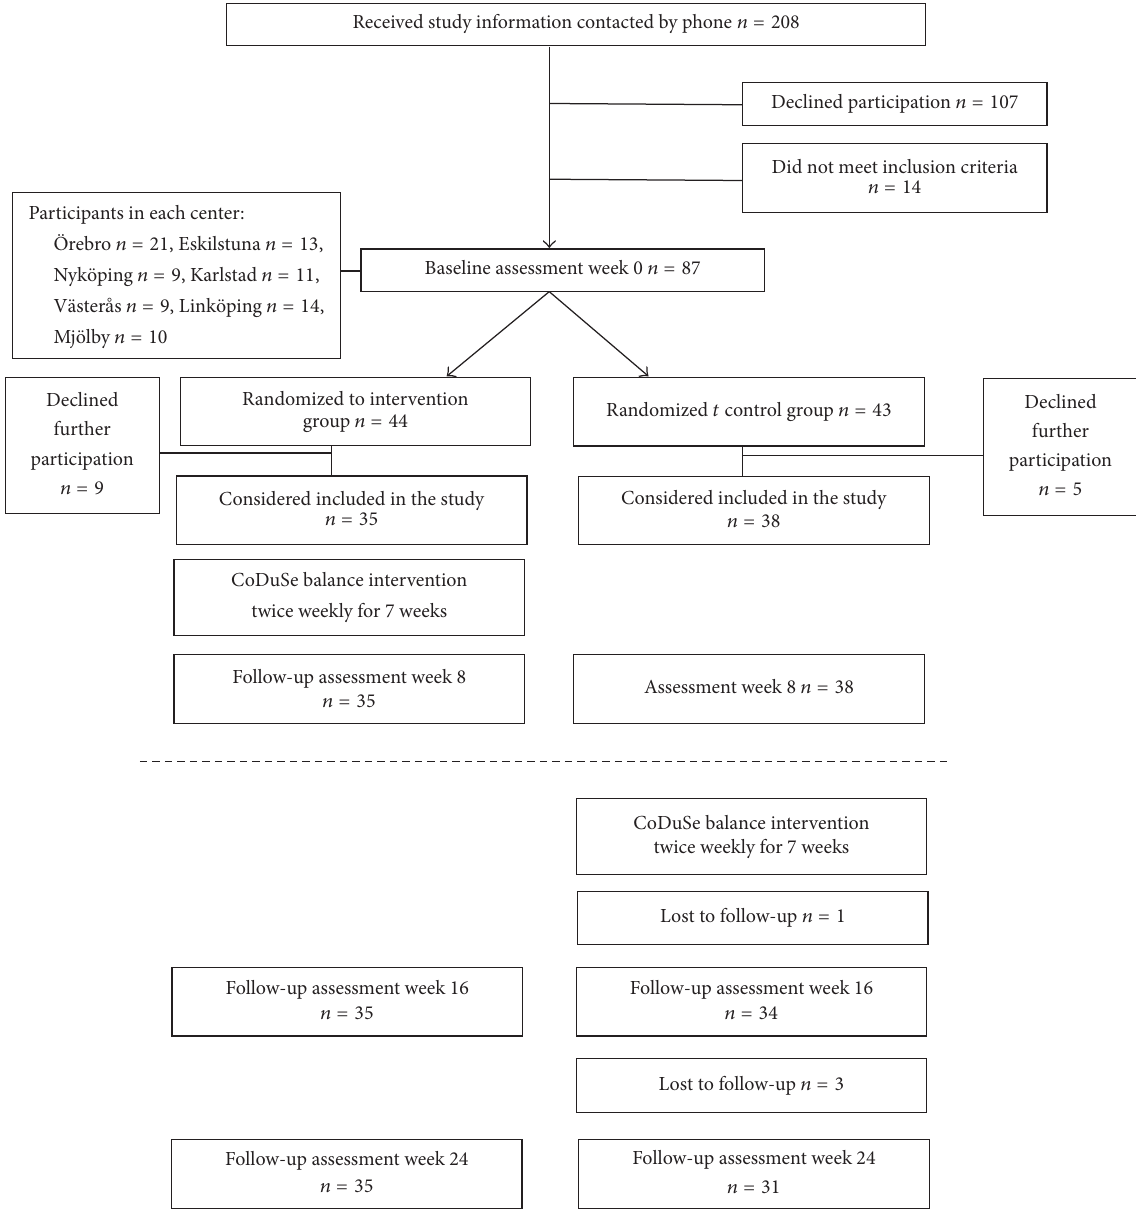
Figure 1: Flow chart of number of participants trough the study. Follow-up assessments at weeks 16 and 24 (below the marked line) are not presented in this